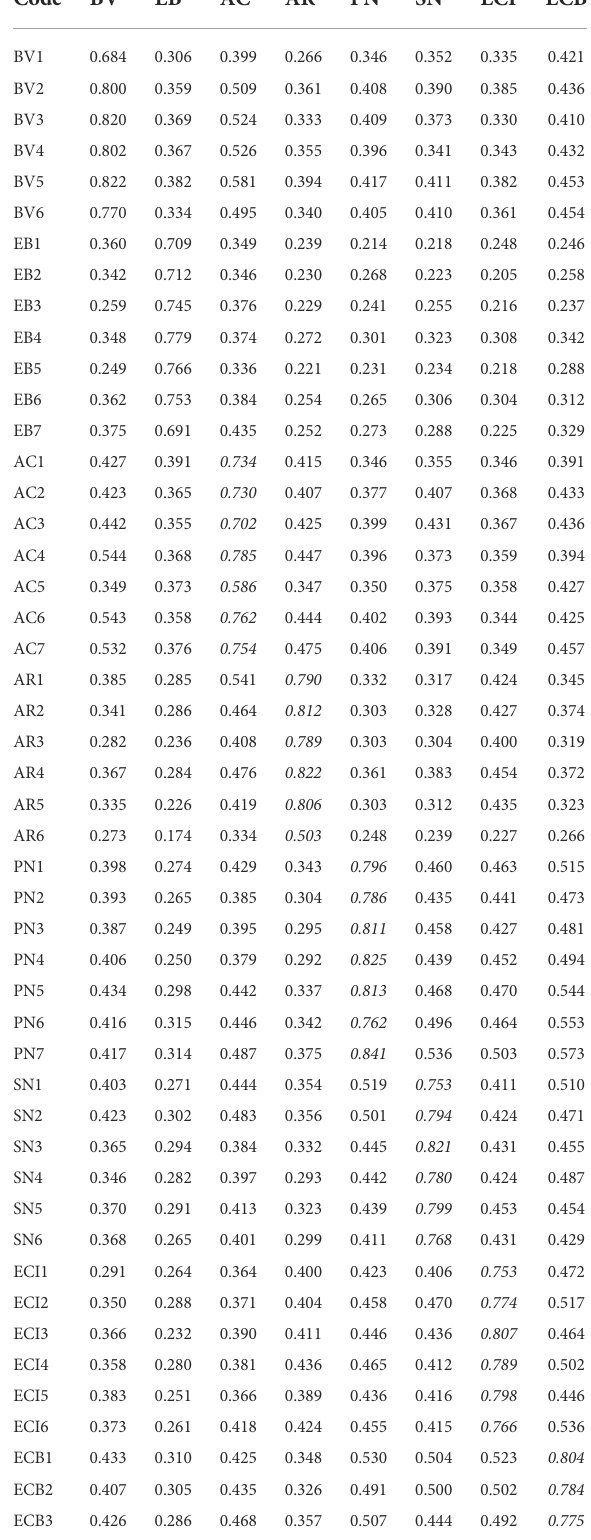
TABLE 5 Loadings and